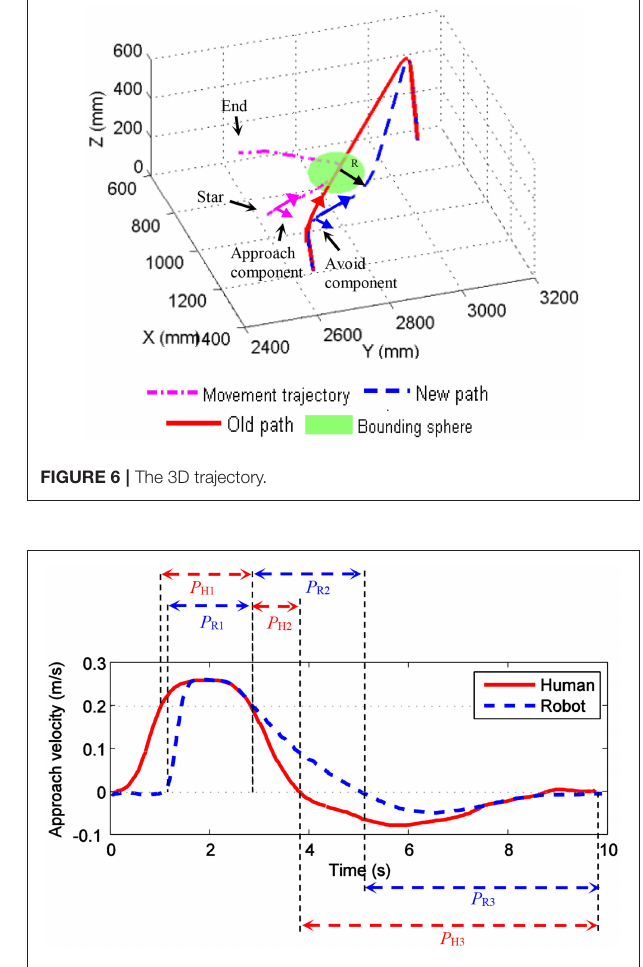
FIGURE 7 | The velocity curve of the human and the robot in the direction of the connections of the human and the robot.